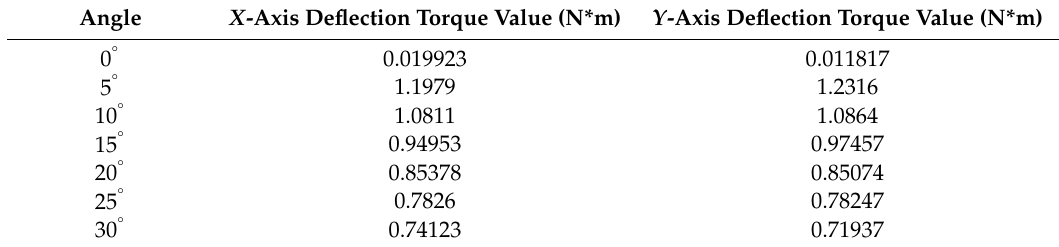
Table 3. Value of deflection torques.